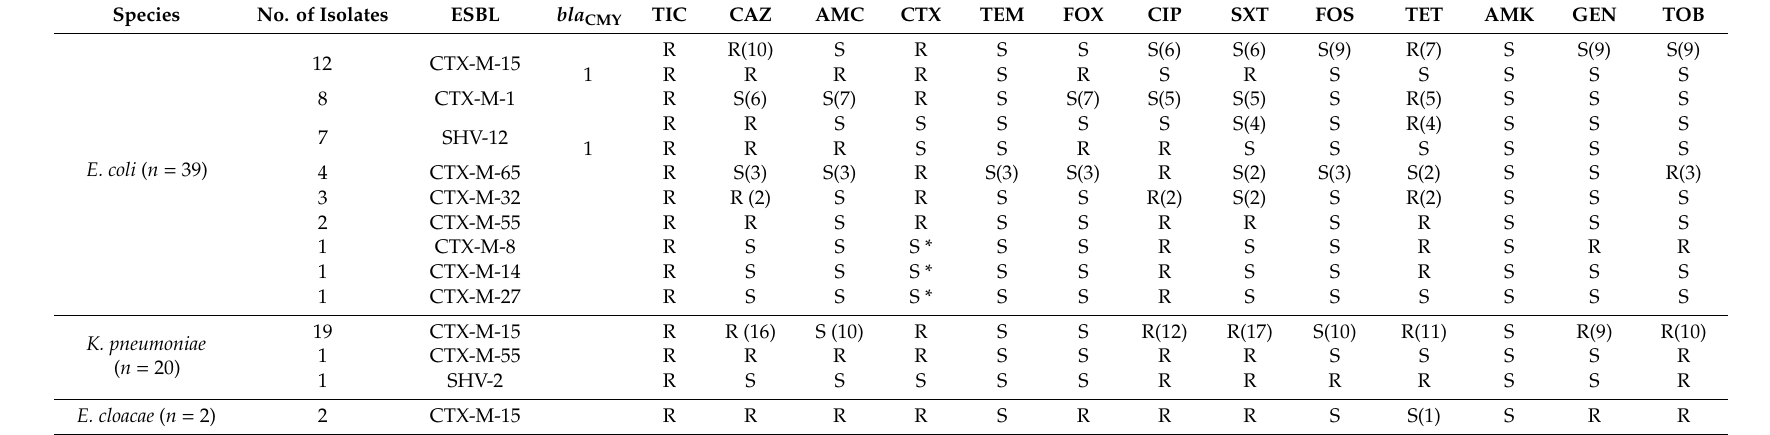
Table 3. Characteristics of the 62 ESBL-producing Enterobacteriaceae